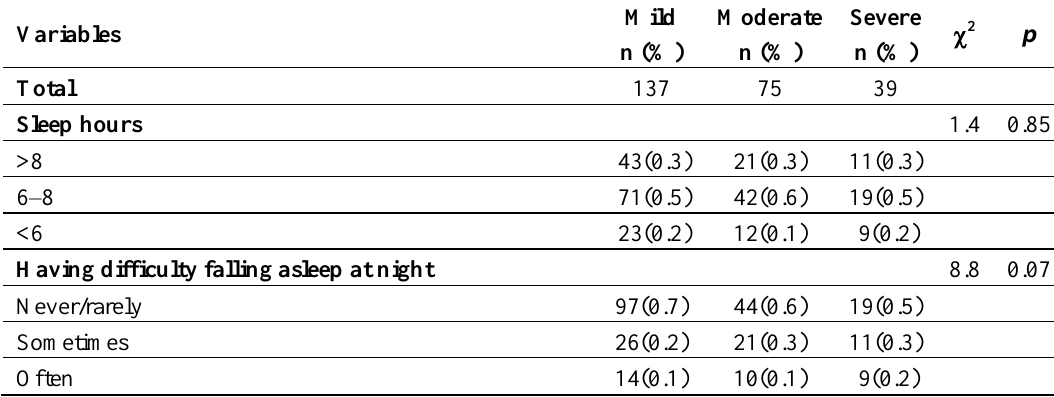
Table 4. Association between sleep-related variables and severity of agricultural work- related injuries among farmers in a northeastern province,